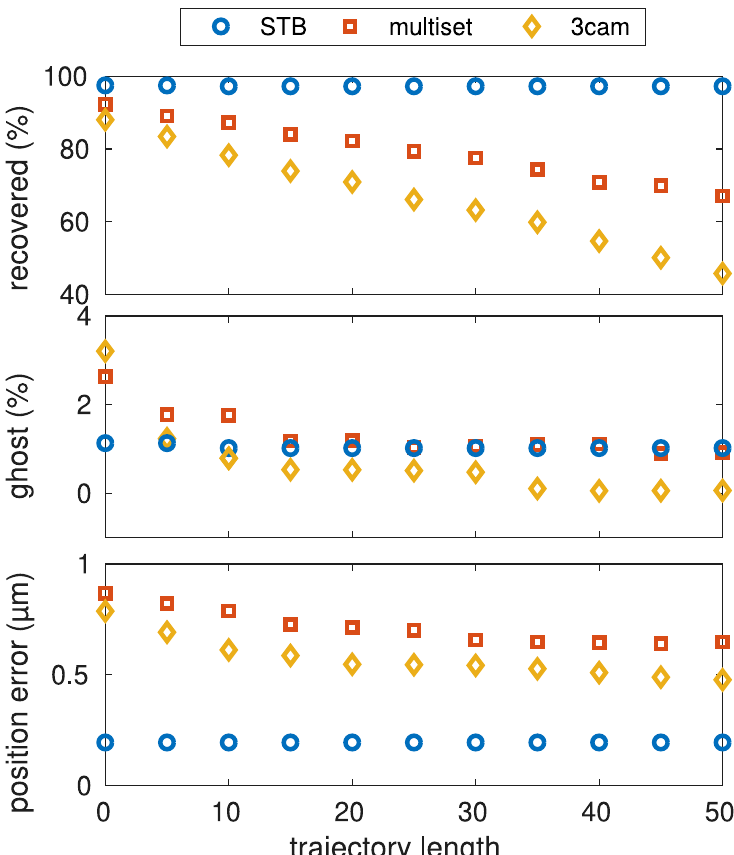
Figure 7. Influence of the minimum trajectory-length criteria on the reconstruction result for a 1000-particle cluster. The shake-the-box algorithm is quite unaffected. The single particle tracking algorithms show a negligible amount of ghost particles when the minimum frame length is above 20frames. Unfortunately, the percentage of recovered particles also declines when the minimum frame length is